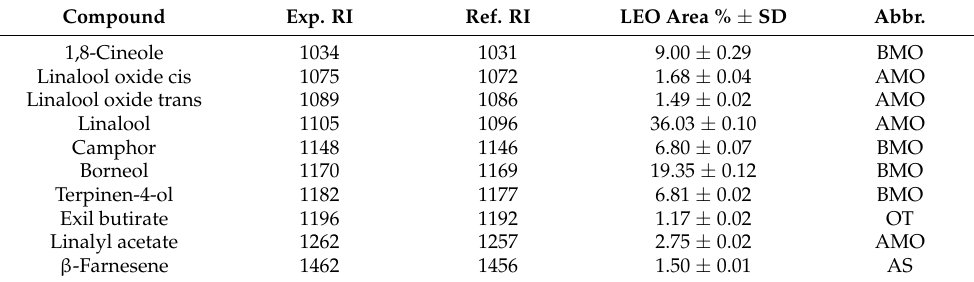
Table 1. Main chemical composition (>1%) of the essential oils (EOs) extracted from the flowers of L. angustifolia . L. AMO—aliphatic monoterpenoids; BMO—bi-and tricyclic monoterpenoids;